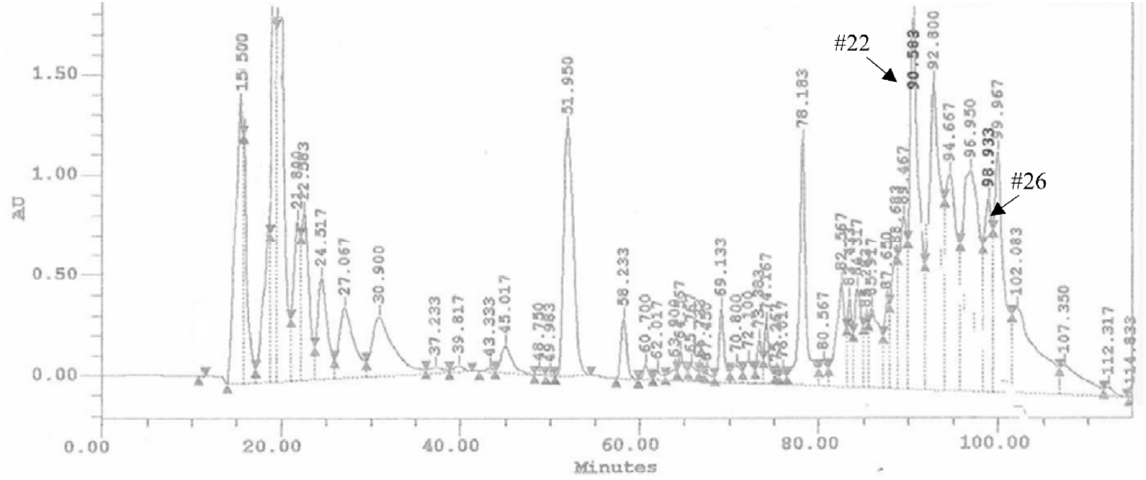
Figure 1. Chromatogram of HPLC analysis of OPs deriving from two equivalent females. Arrows show the retention times related to the biologically active fractions: fractions #22 and #26, respec- tively.